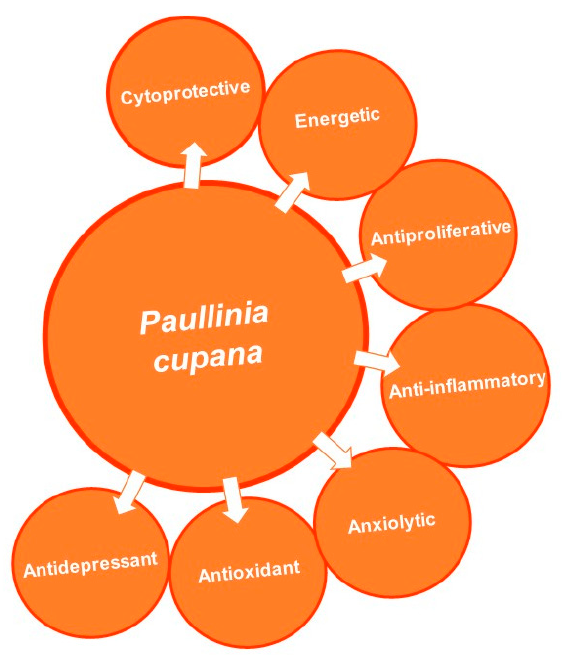
Figure 1. Biological effects of Paullinia cupana .